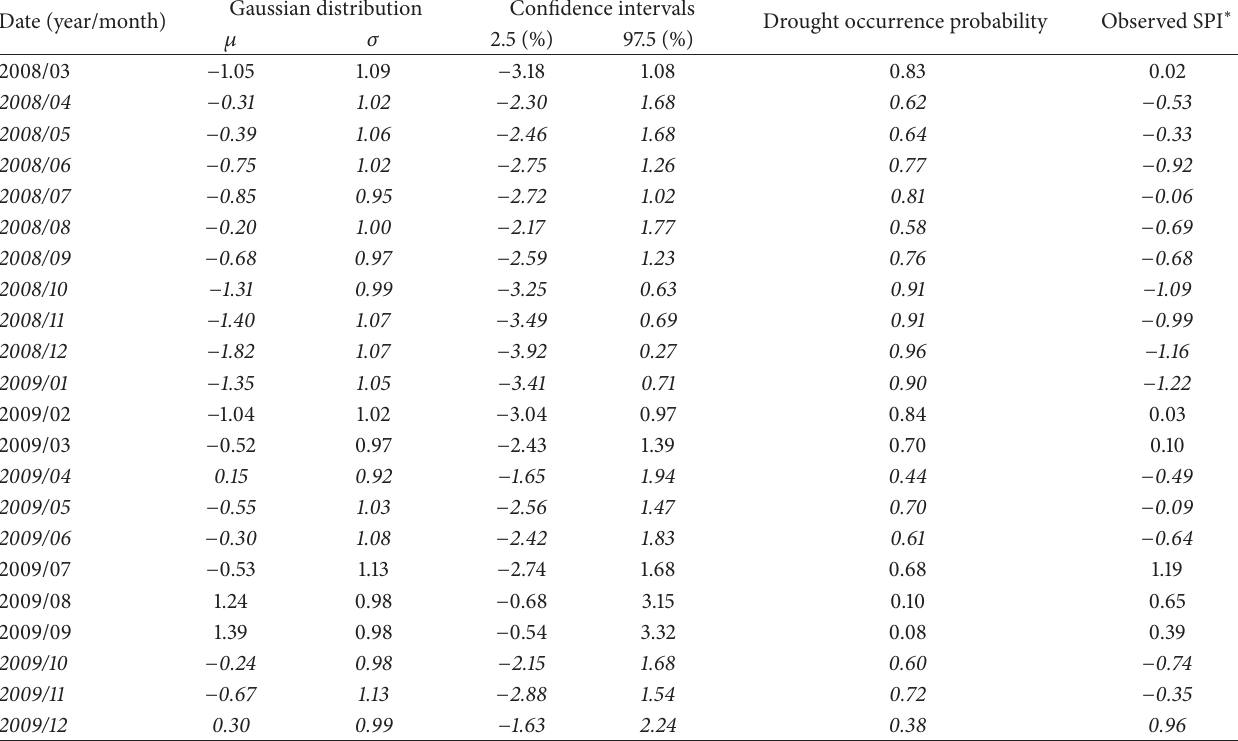
Table 1: Results of drought forecasting in Wonju station during September 2008 to December 2009 ( ∗ the drought conditions (observed SPI is under zero) are in italic font in the table).